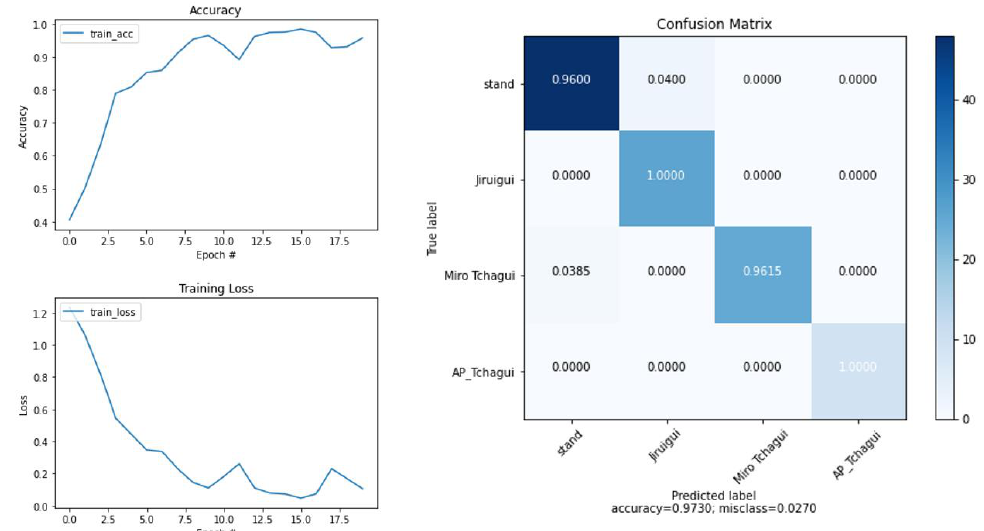
Figure 15. Training results and confusion matrix from ConvLSTM model.